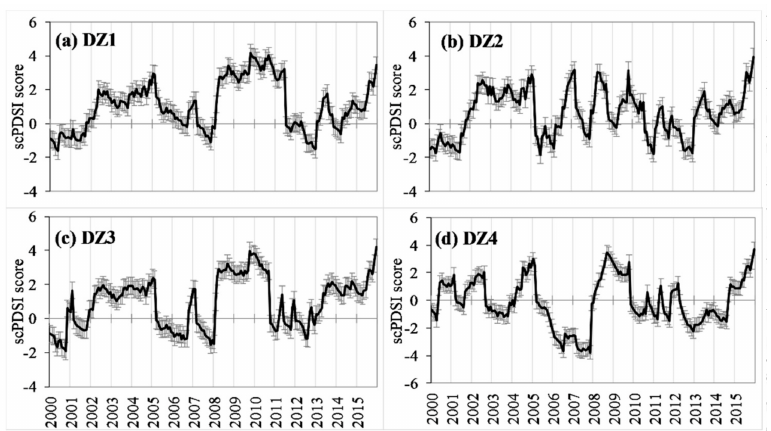
Figure 5. Plots correspond to the spatial average scPDSI ( ± SD) for each drought zone, estimated from the original monthly scPDSI data ( a – d ). Zero indicates a normal year, and negative number indicate dry conditions. We can consider a severe or extreme drought occurred when the value ≤−